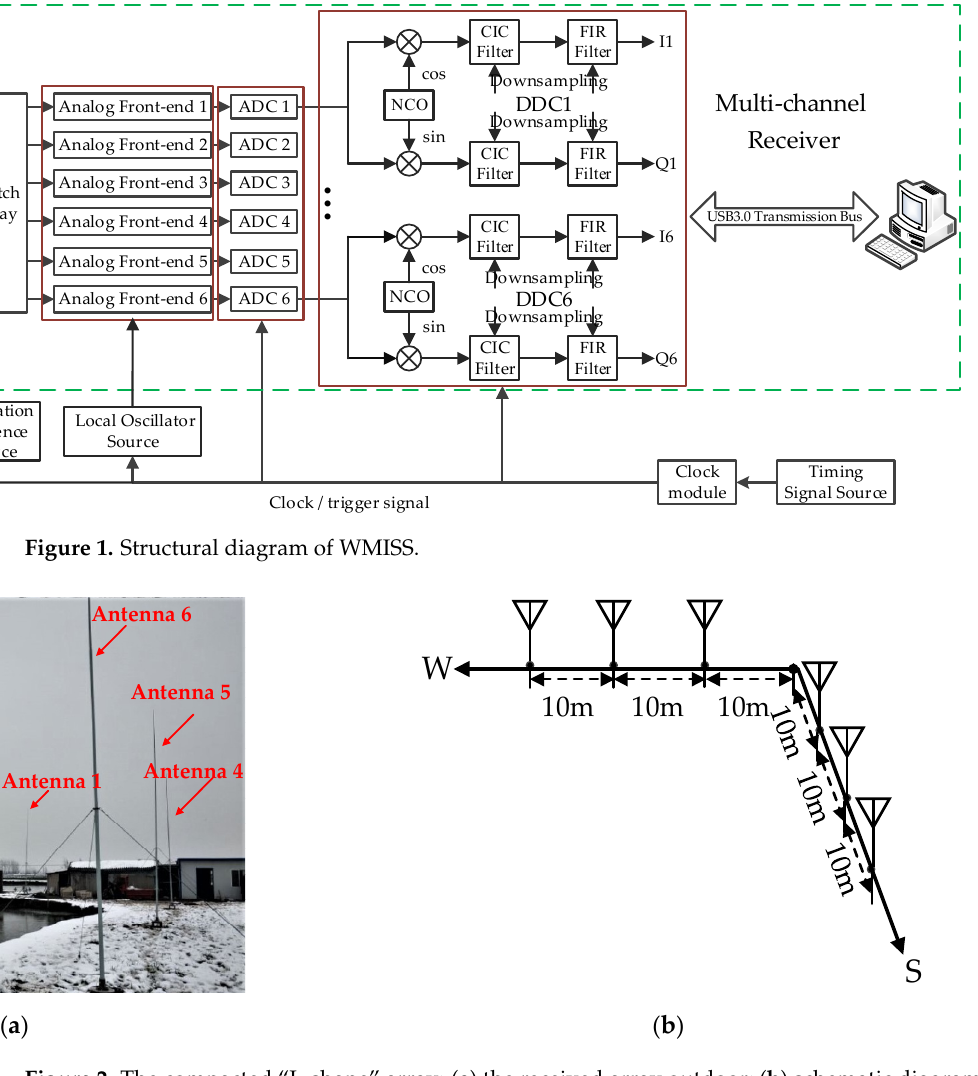
Figure 2. The compacted “L-shape” array: ( a ) the received array outdoor; ( b ) schematic diagram of antenna direction and spacing.